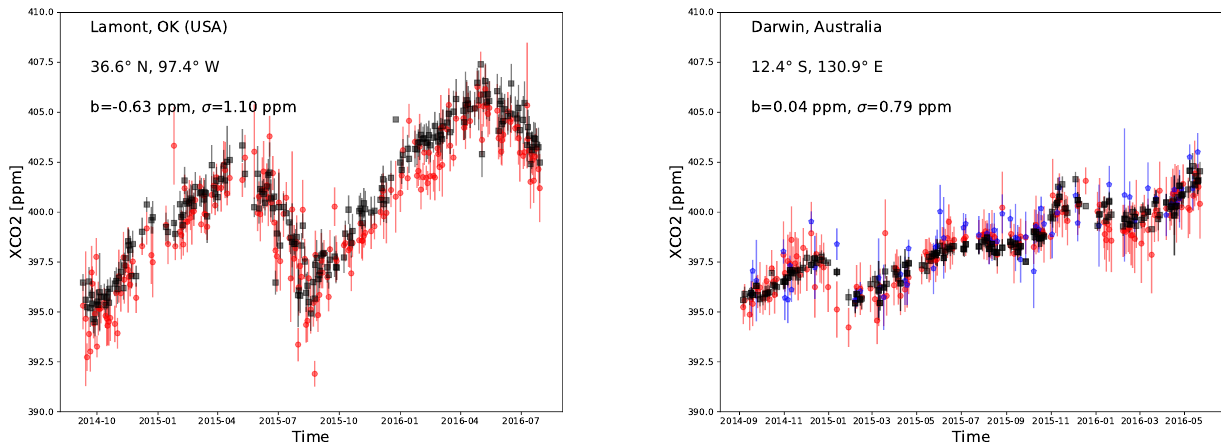
Figure 1. Time variation of X CO retrievals from OCO-2 observations over land (red dots) and ocean (blue pentagon) and collocated TCCON 2 measurements (black square) for Lamont and Darwin stations. SD of individual TCCON measurement and satellite retrievals are presented with the length of bar. In each subplot, the mean bias ( b ) and SD ( σ ) of the difference between RemoTeC/OCO-2 retrievals and TCCON measurements and site location in latitude and longitude are included. The shown results here are bias-corrected data.